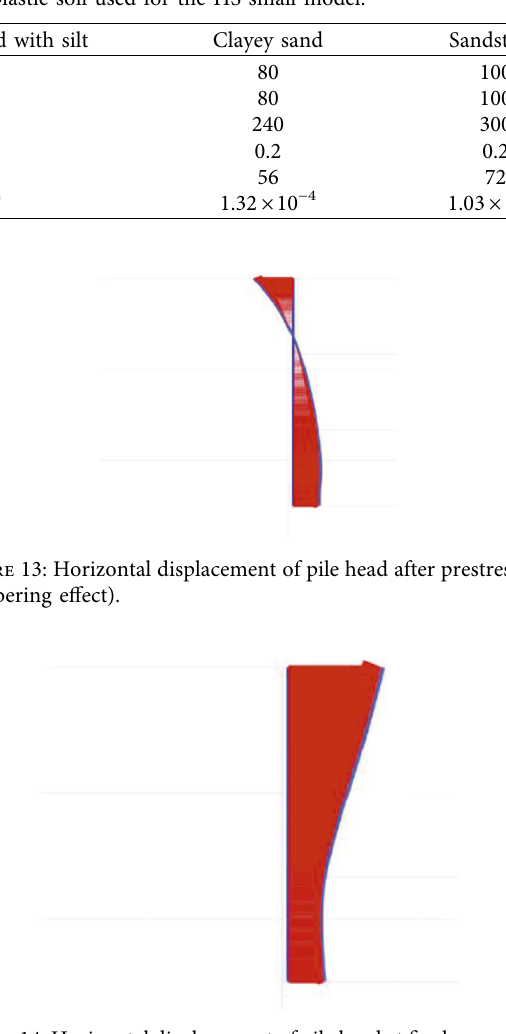
Figure 14: Horizontal displacement of pile head at final excavation